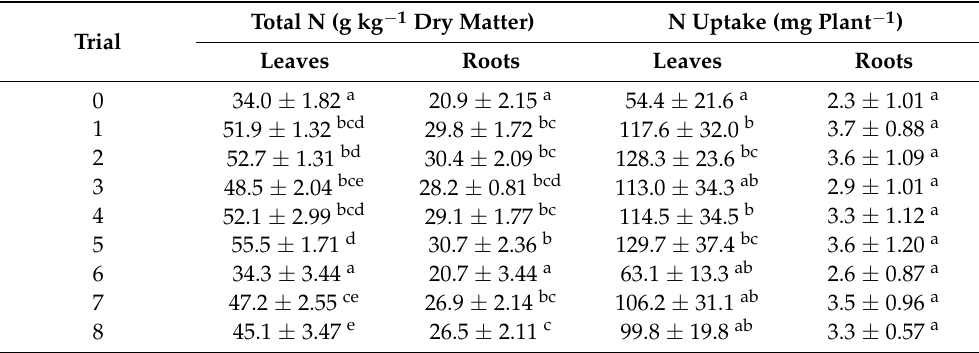
Table 4. Total nitrogen concentration and N uptake for spinach plants (mean value ± standard deviation) 1 cultivated in trials 0–8.